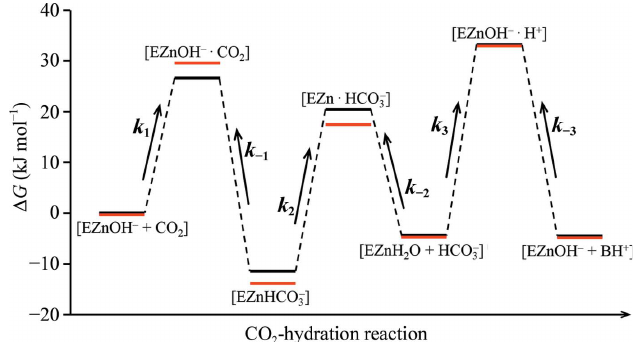
Figure 5 Estimated free-energy profiles for the CO 2 -hydration reaction catalyzed by CA II. The energy states of native CA II (black) are from a previous study (Behravan et al. , 1990). The energy states of V143I CA II (red) are qualitatively estimated with respect to the native form by considering the structural information and the variations in the reaction rate constants. Note that the energy level of [EZnH 2 O + HCO 3 (cid:2) ] in the V143I variant is assumed to be the same as that in native CA II. The depicted energy gaps are not to